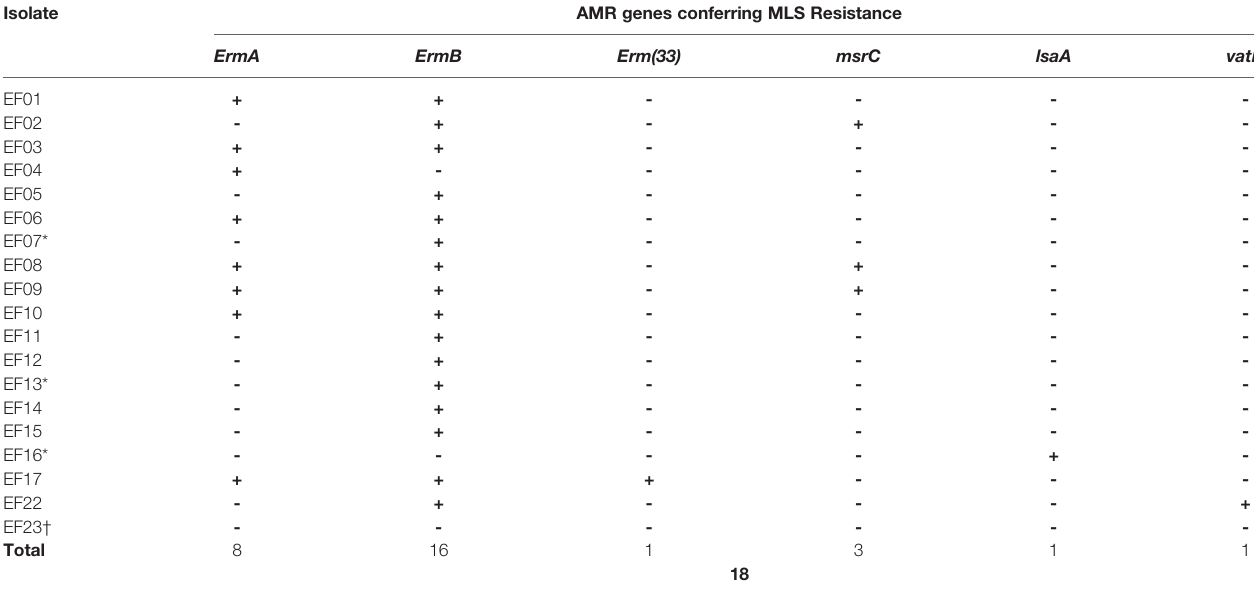
TABLE 8 | Genes detected by long-read next-generation sequencing that confer antimicrobial resistance (AMR) to macrolide – lincosamide – streptogramin (MLS).